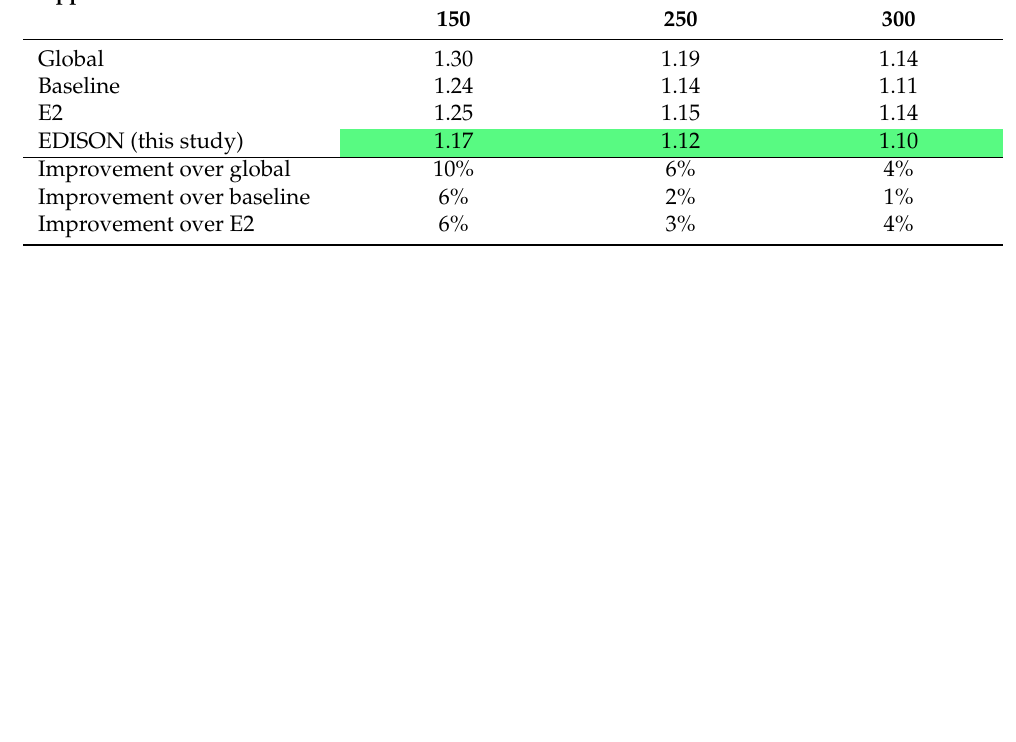
Table 3. RMSEs of EDISON and the alternatives. Best results in each column highlighted in green.